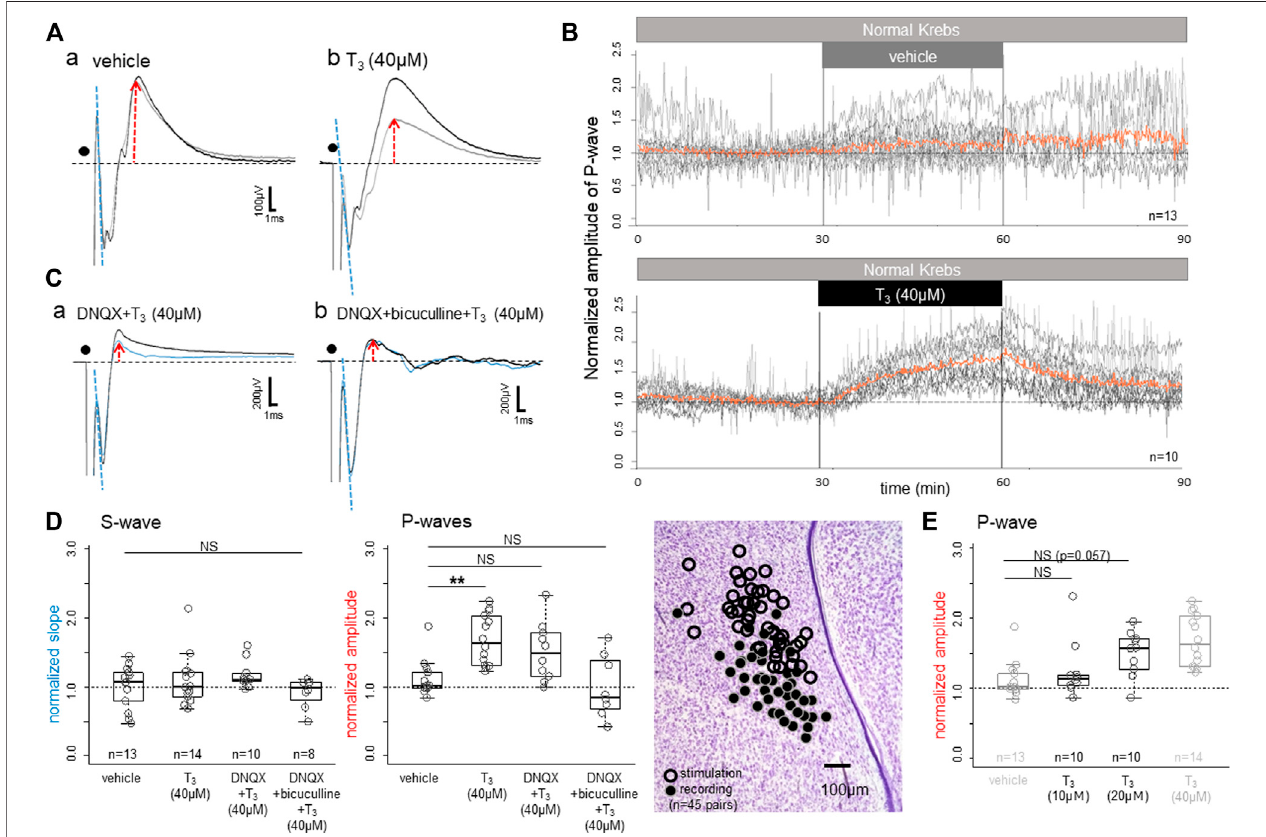
FIGURE2| Effectsofbath-appliedT 3 onthe fi eldpotentialresponsestolocalelectricalstimulationintheIMM. (A) Superimposedaveragedtraces(~30successive responsesat10 sintervalsin (A,C) before(thingreytraces)andafter(thickblacktraces)applicationofvehicle (Aa) andT 3 (40 μ M; (Ab)) . (B) TimecourseoftheT 3 effect. Superimposedplotsareshownforthevehiclecontrol(top)andT 3 (bottom);orangelinesindicatethepopulationaverage. (C) T 3 wasbathappliedaftertheslicehadbeen treated with DNQX (Ca) or DNQX + bicuculline (Cb) : the thin blue traces denote the pre-T 3 responses. (D) T 3 effects on the normalized slope of the S-wave (left; initial negative slope) and P-wave amplitudes (middle and right; peak amplitude). Note that the T 3 effect survived even in DNQX, but not in DNQX + bicuculline (middle). Sites of stimulation and recording ( n = 45 slices) are plotted. (E) Dose dependence of the T 3 effects on the early P-wave; the vehicle control and the T 3 (40 μ M) data are duplicated(showningrey)forcomparison.Normalizationoftheslope/amplitudewasdoneagainstthosecontrolrecordsduringthelast5 min(i.e.,30trials)ofthecontrol condition before T 3 was applied. NS denotes not signi fi cant. Asterisks denote the level of signi fi cance as; * ( p < 0.05), ** ( p < 0.01) and *** ( p < 0.001).